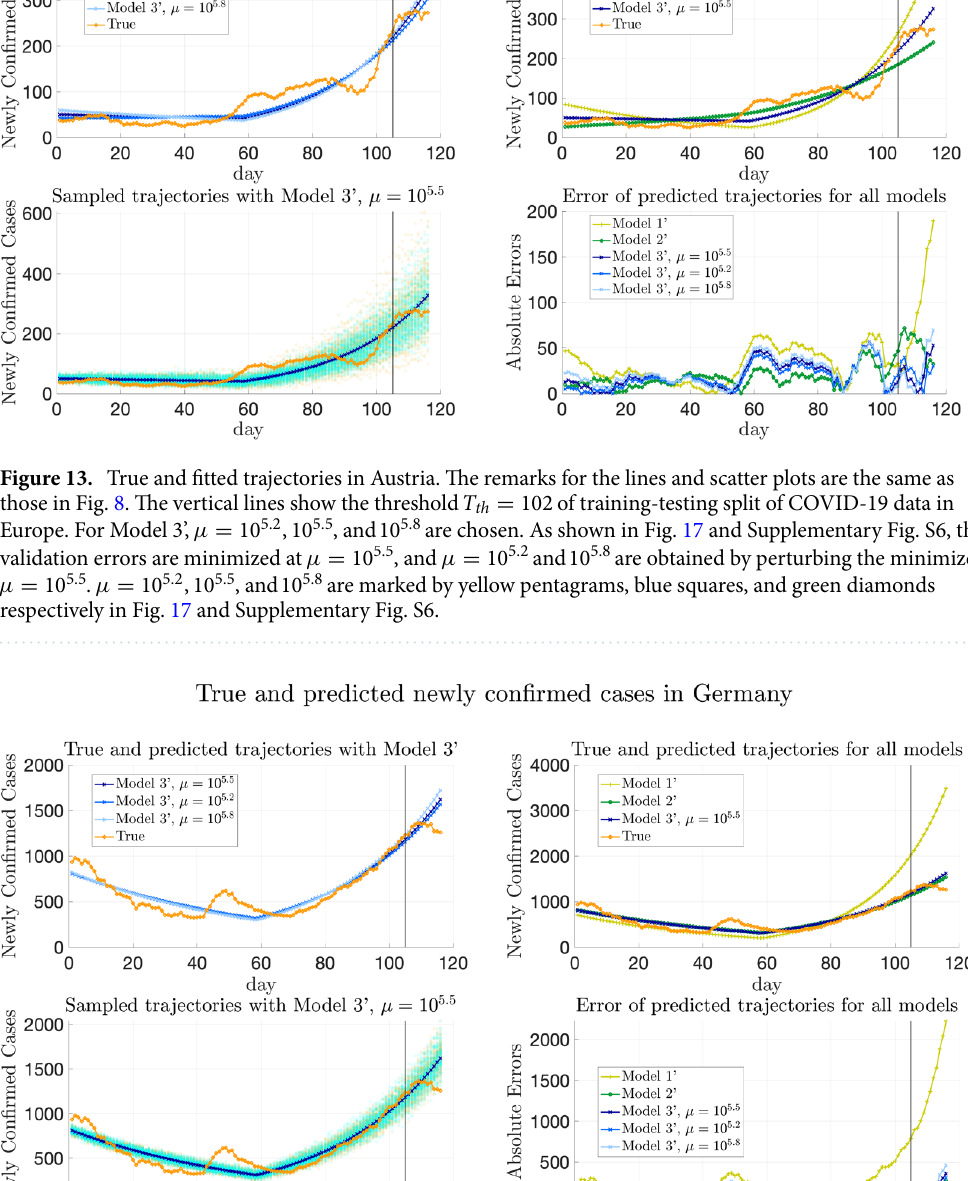
Parameter inference of the three models. By the time-varying extension (4.3) detailed in “Model extension by allowing time-varying parameters”, for Model 3’, � = { E k ( 0 ) , H k ( 0 ) , (cid:31) optimization problem in (4.5):